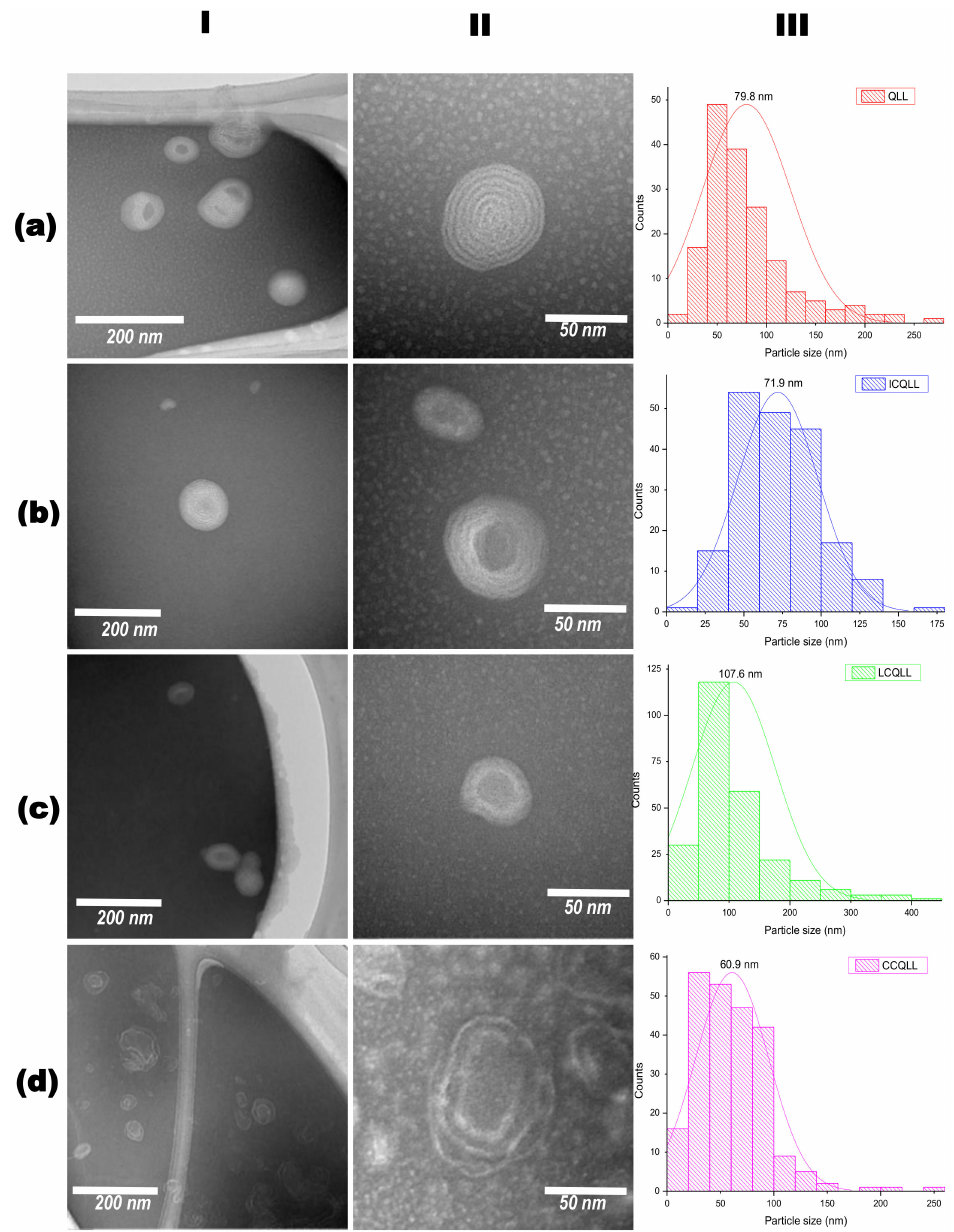
Figure 3. BF TEM images of uncoated and coated quercetin loaded liposomes. ( a ) QLL, ( b ) ICQLL, ( c ) LCQLL, ( d ) CCQLL. Column I and II show low and high magnification micrographs, respectively, column III shows the particle size distribution measured from the TEM